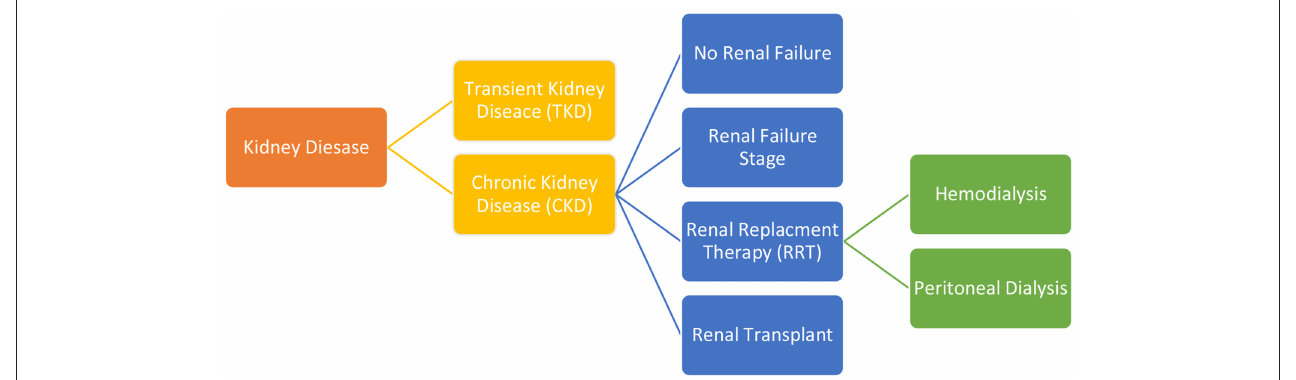
FIGURE 1 | Patients study groups.